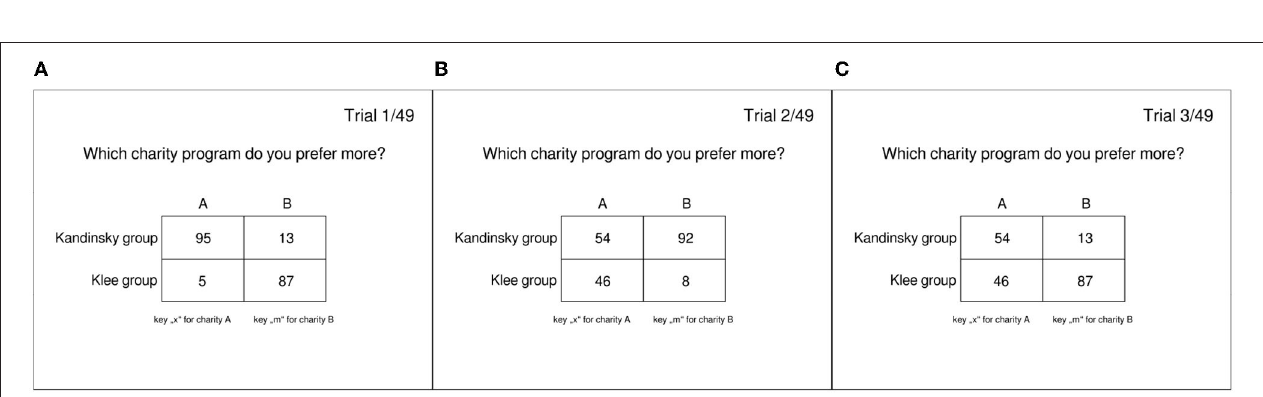
FIGURE 2 | Example of the three stimulus types. Left (A) stimulus type 1 (low difficulty), middle (B) stimulus type 2 (medium difficulty), right (C) stimulus type 3 (high